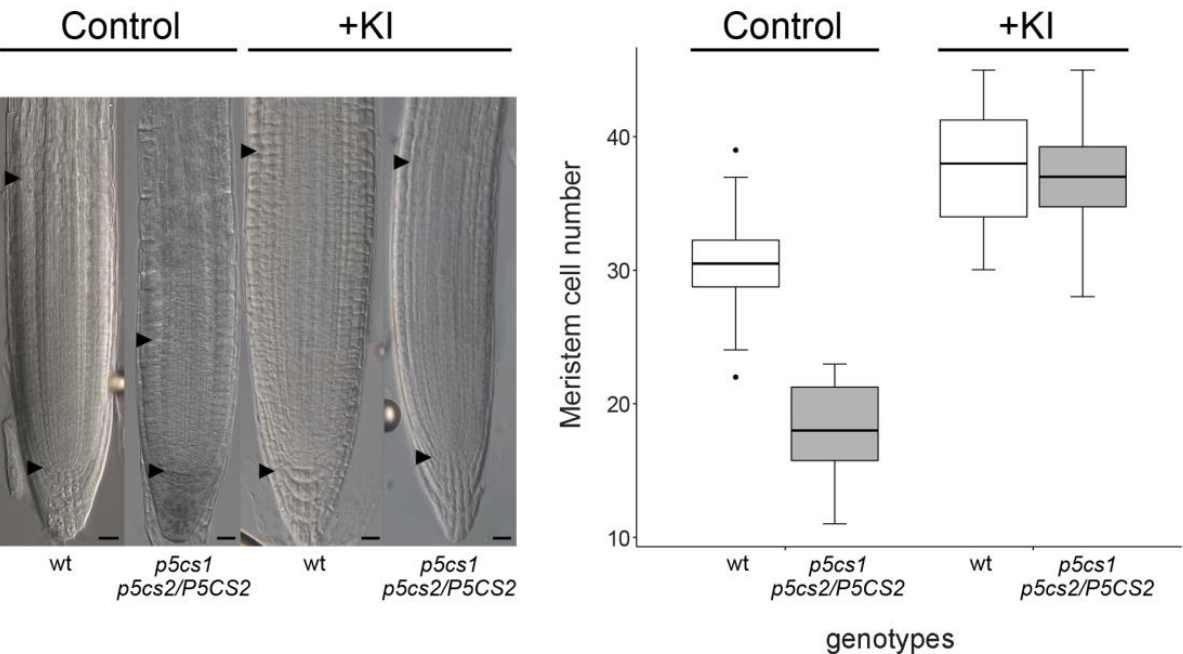
Figure 5. Effect of KI on the root meristem size of wildtype and proline-deficient mutants. ( Left panel ) Root meristem from wildtype and p5cs1 p5cs2/P5CS2 treated, at 5 DAG, with 10 µ M exogenous KI, a strong scavenger of hydrogen peroxide. Black arrowheads indicate the quiescent center (bottom arrowhead) and the transition zone (top arrowhead). Bar = 50 µ m. ( Right panel ) Boxplot representation of the average number of meristem cells in a wildtype and p5cs1 p5cs2/P5CS2 genotype in the presence or absence of KI treatment. A two-way ANOVA analysis revealed a significant interaction between KI and P5CS expression in the modulation of root meristem size. Pairwise comparisons with Tukey post-hoc correction were used to analyze differences between individual samples. All pairwise comparisons were significant at p < 0.001, except wildtype plus KI versus p5cs1 p5cs2/P5CS2 plus KI which was non-significant. Each box represents the mean of at least three independent experiments, each one replicated three times and comprising ten roots.